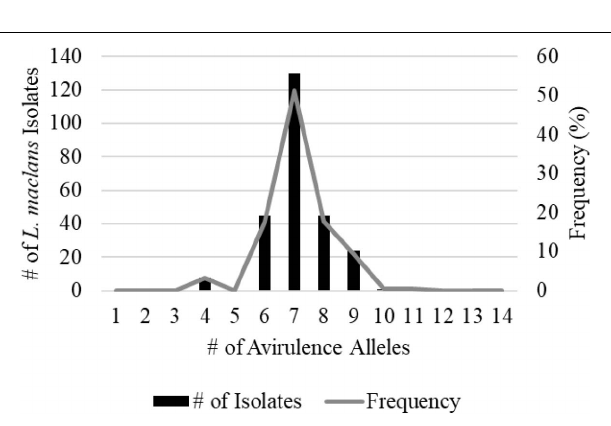
FIGURE 4 | Leptosphaeria maculans race complexity based on a total of 254 isolates from Manitoba in 2018–2019 assessed at 14 avirulence alleles.